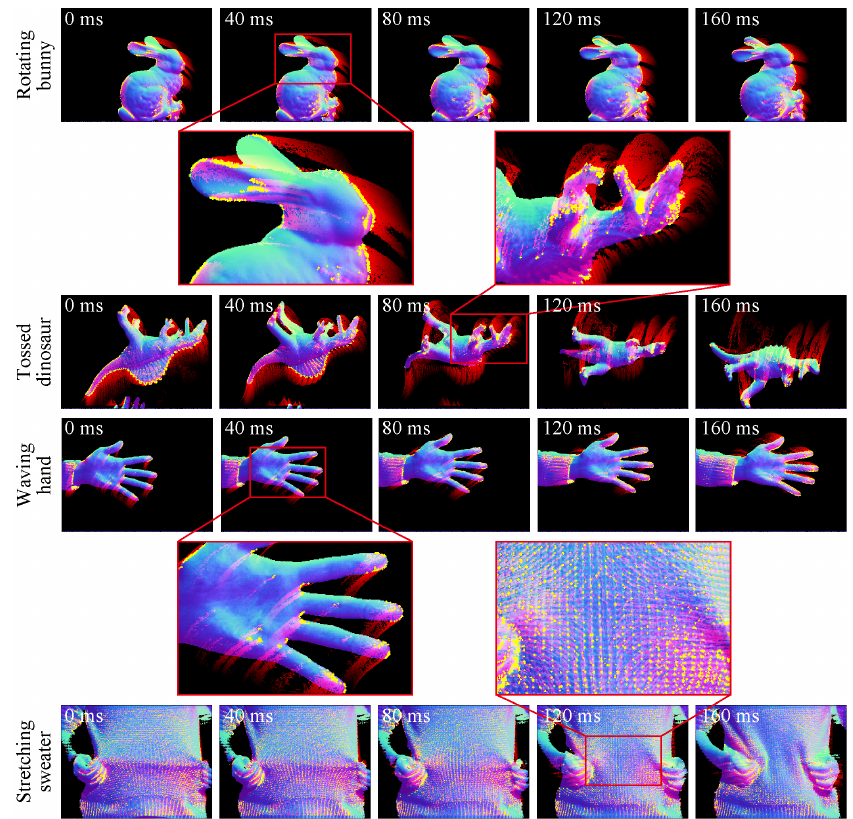
Figure 8. Motion tracking in actual scenes. From top to bottom, figures show scenes of rotating bunny, tossed dinosaur, waving hand and stretching sweater. Yellow dots and red fading strokes respectively show interest point having unique matches and trajectories of the interest points as Figure